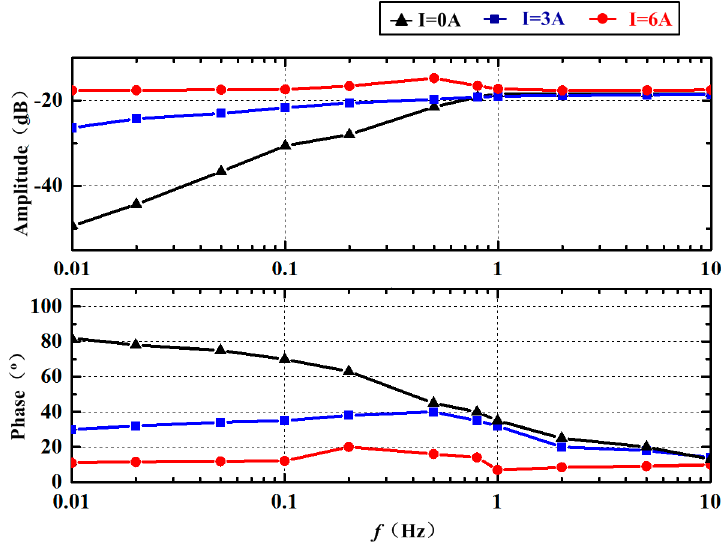
Figure 14. Frequency response experimental results of C-MHD ARS.